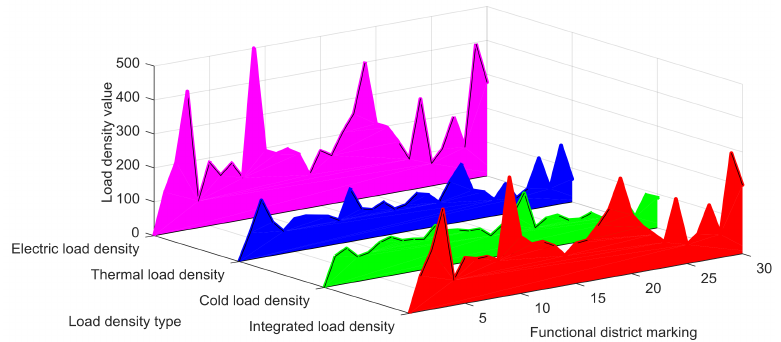
Figure 10. The load density value of each functional